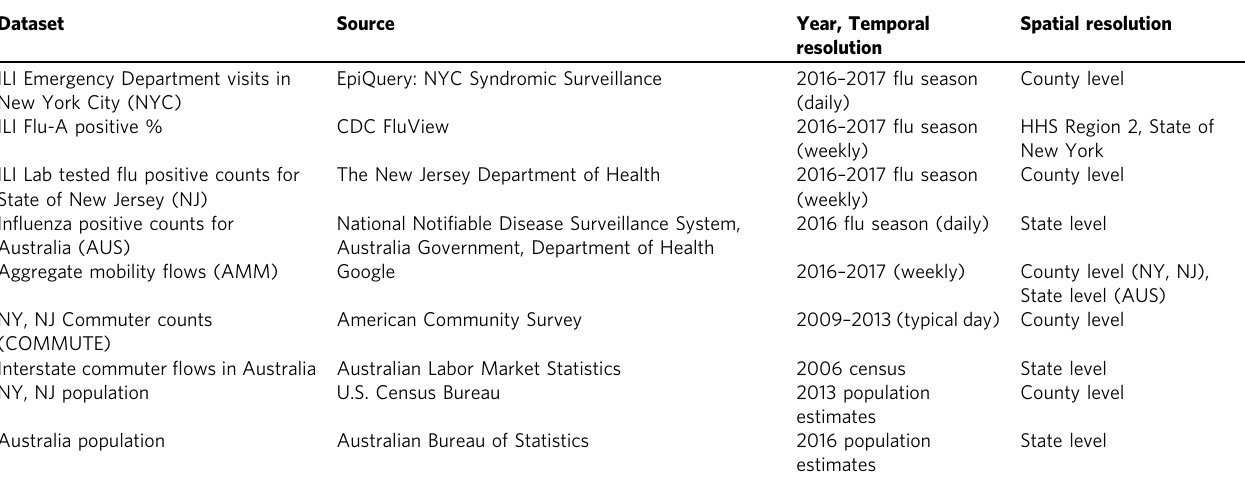
Table 1 List of